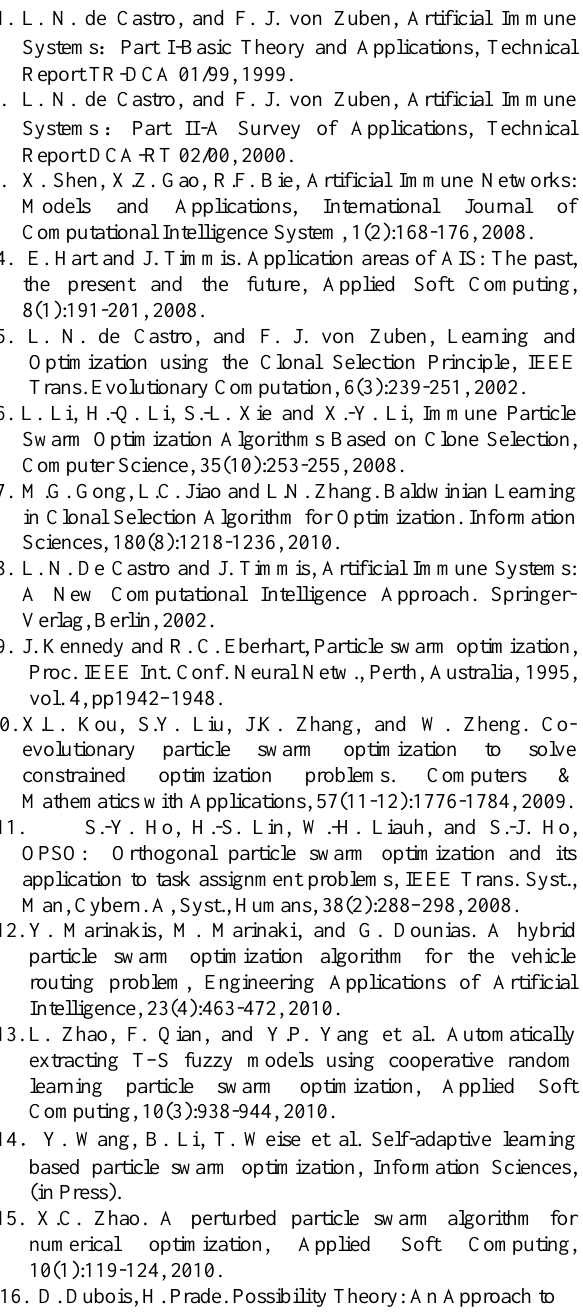
Table 15. Results of function 11 with increasing dimension f11 Algo.